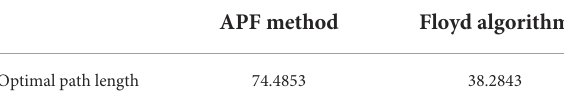
TABLE 1 Comparison of boot paths